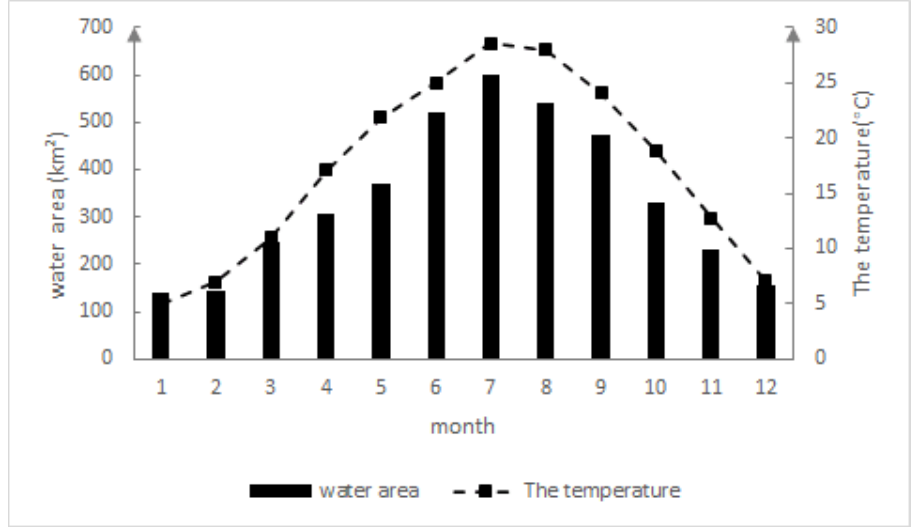
Figure 7. Comparison of monthly changes in temperature and the water area of the seasonal